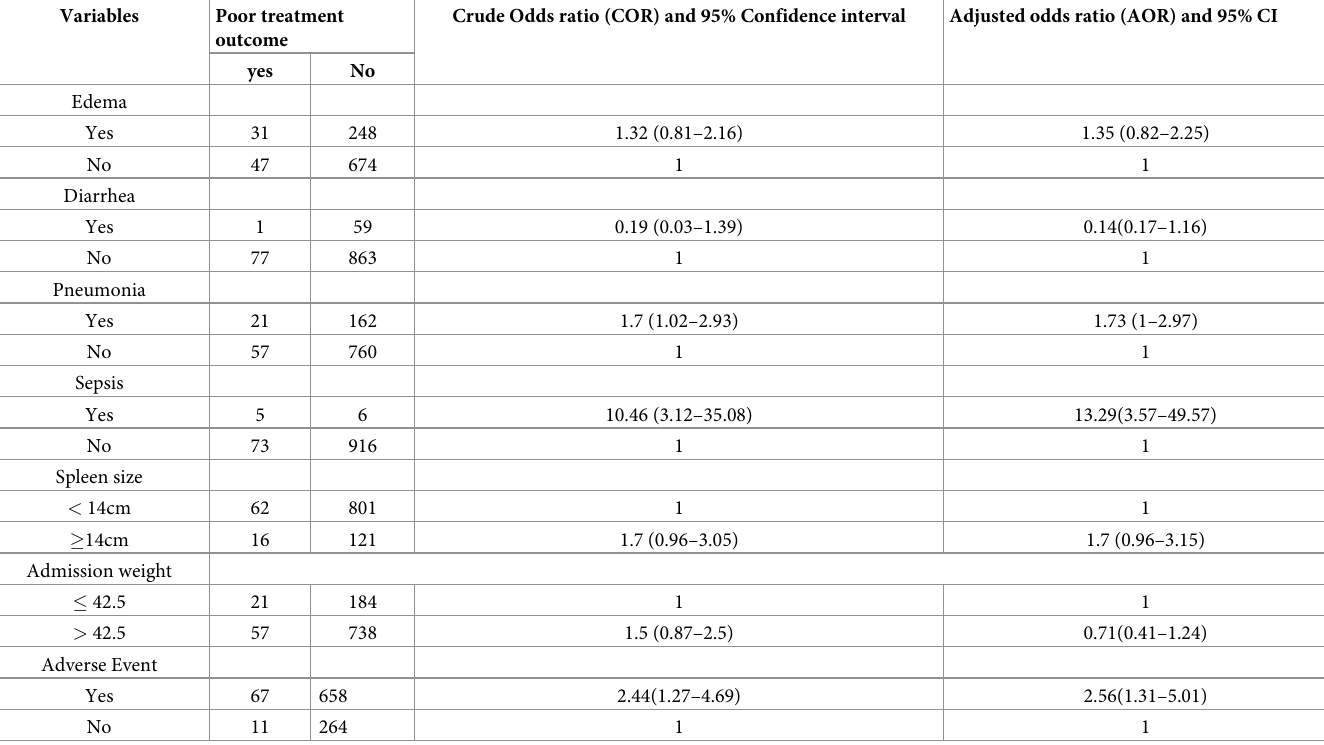
Table 4. Associations of selected variables and Poor Treatment Outcomes (N =